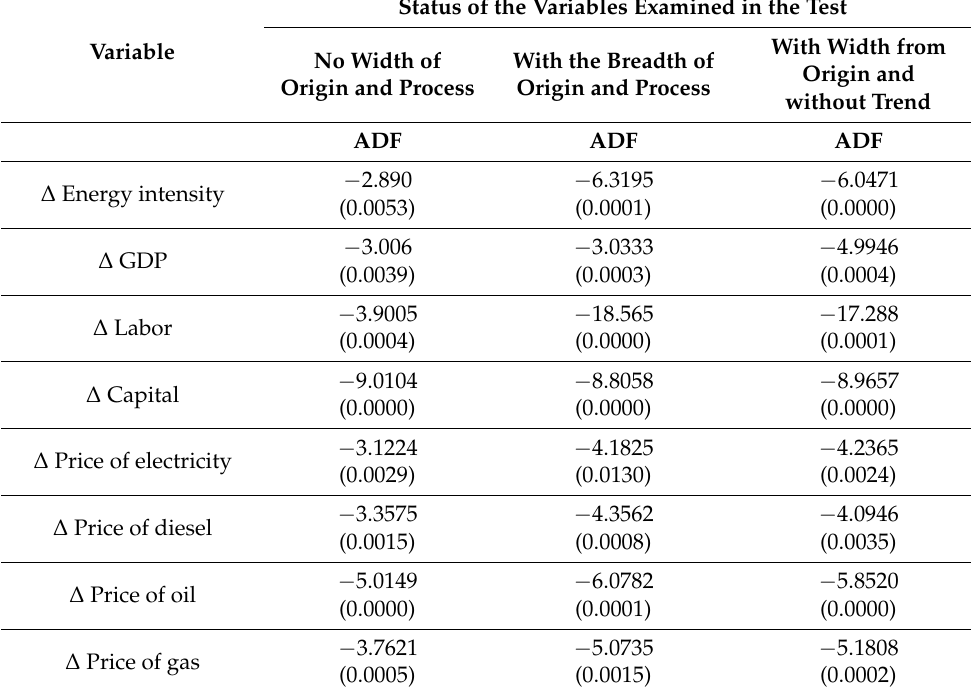
Table 3. ADF Test results for variables in the first-level